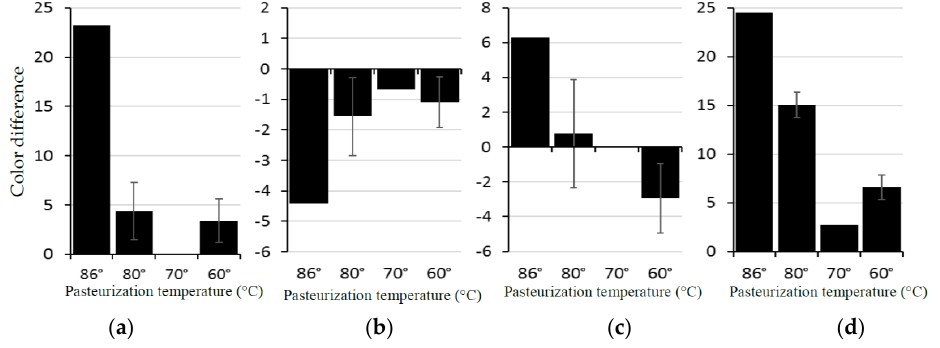
Figure 2. Variation of color parameters for different pasteurization temperatures. ( a ) L*, ( b ) a*, ( c ) b* and ( d ) color difference. Each bar represents the difference with the unpasteurized juice. For 86 °C, n = 1; for 80 °C, n = 2; for 70 °C, n = 1; and for 60 °C, n = 4.